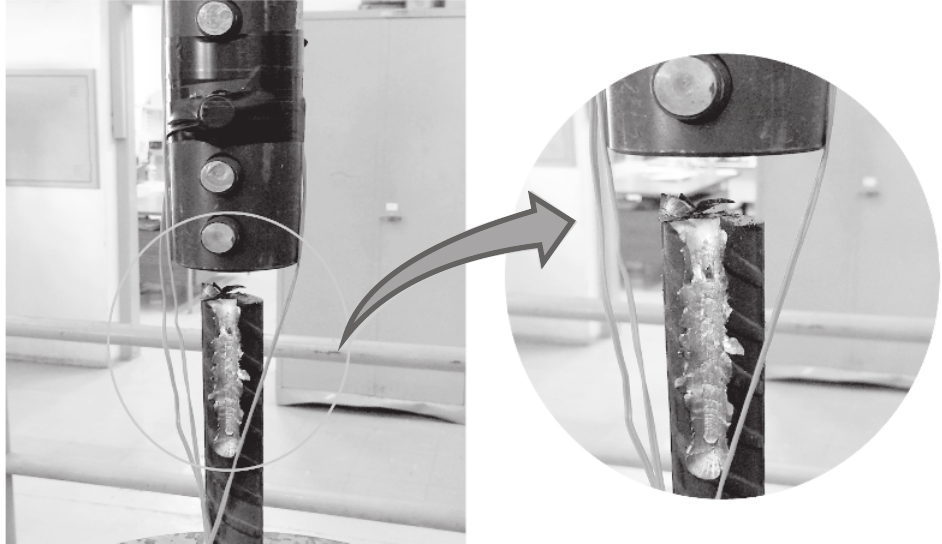
Detailed view post-rupture of spliced bar with shear bolted